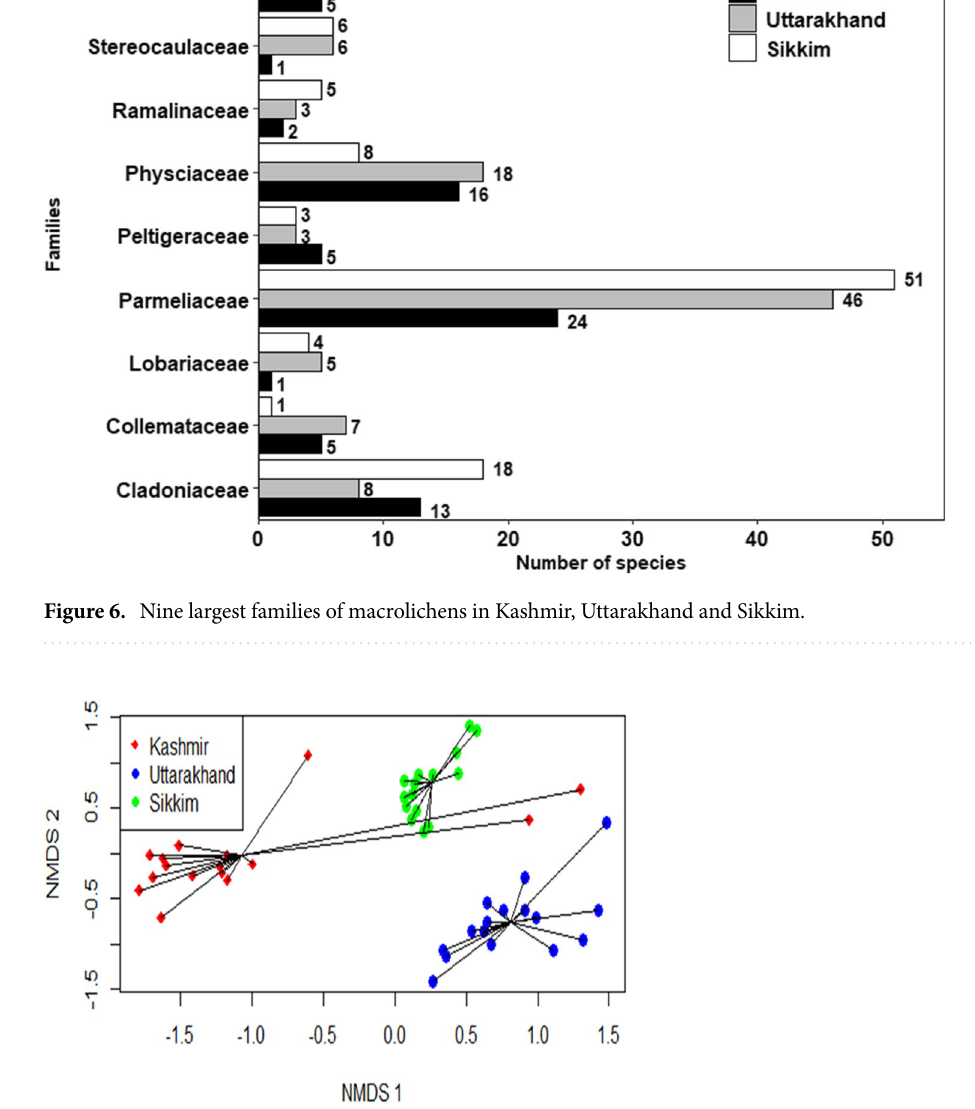
Figure 7. NMDS based on Bray–Curtis dissimilarity index for three elevation transects. The graphical plot represents the species compositions of three transects over 16 common elevation bands (communities) in an elevation span of 2200–3700 (m a.m.s.l.).